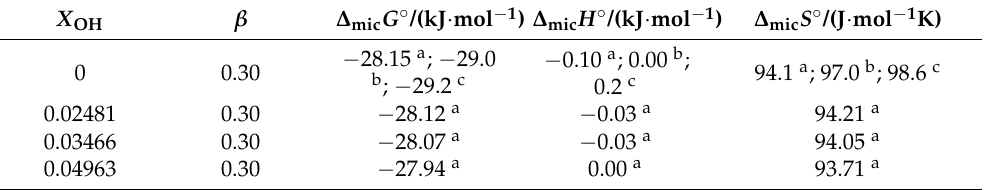
Table 6. Standard values of the micellization thermodynamic parameters: Gibbs energy ( ∆ mic G ◦ ), enthalpy ( ∆ mic H ◦ ), and entropy ( ∆ mic S ◦ ) at the critical micelle mole fraction and degree of micelle ionization β of decyltrimethylammonium bromide (C 10 TAB) in water and in aqueous solutions with different mole fractions of 1,2-propanediol at 298.15 K and 75 kPa. X